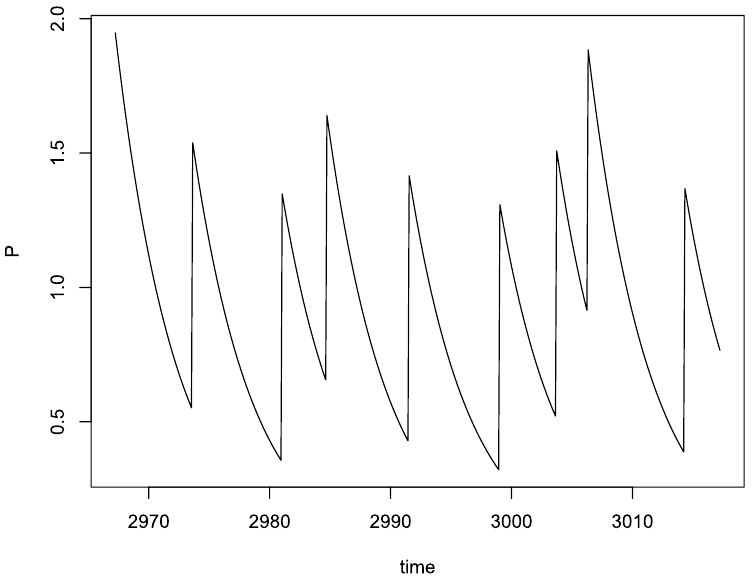
Figure 1. Time course of the pathogen load within a single susceptible individual: booster events (uptake of pathogens) instantaneously increase the load, in-between two booster events the immune system leads to an exponential decrease in pathogens. The time between two booster events is given by i.i.d. random variable T . ψ B = 1 is taken constant here, the initial time span is dismissed as a burn-in phase s.t. time runs here from 2970 to